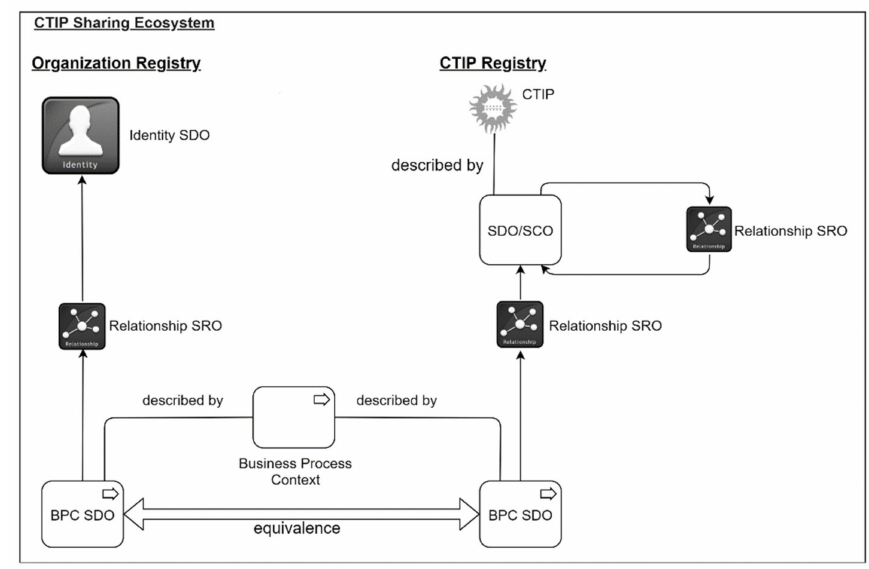
Figure 5. Business Process Context representation in a CTIP sharing